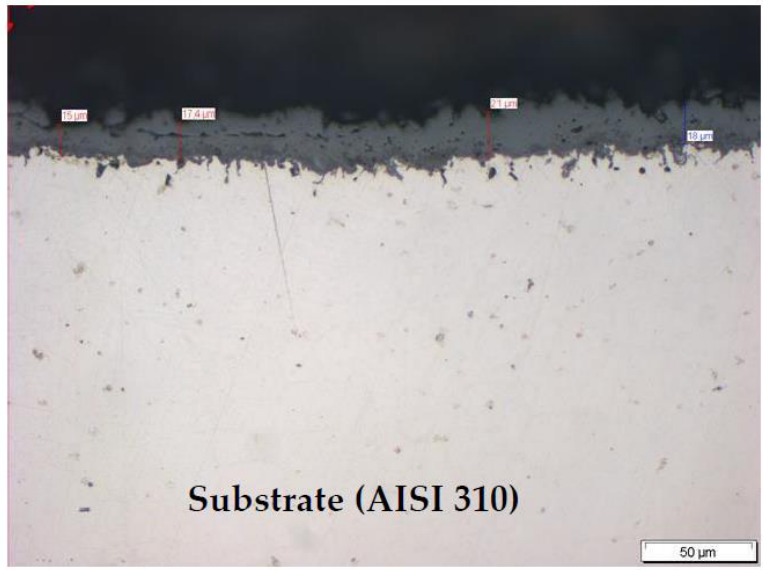
Figure 14. Oxide layer in AISI 310 sample.